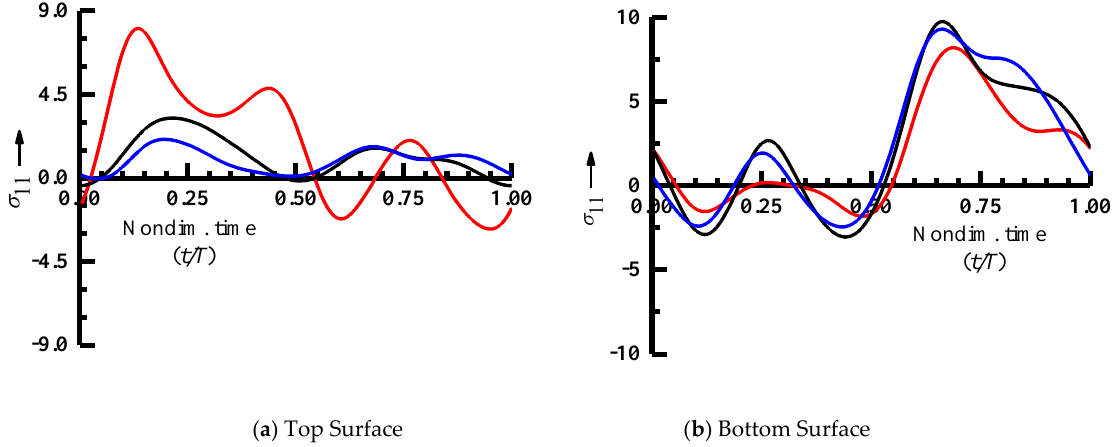
The center of the bottom surface is subjected to partly tensile and partly compressive stress during a periodic cycle with a greater tensile portion during a cycle for all the sector angles considered. The stress amplitude at the center of the bottom surface is smaller for the sector plate with a sector angle of 60 ◦ compared to a sector angle of 90 ◦ and 120 ◦ . Furthermore, there are multiple slope changes and stress reversals during a periodic cycle corresponding to a single loading cycle for laminated annular sector plates for all the sector angles considered, revealing significantly large higher harmonic contributions. The Fast Fourier Transform of the steady state stress at the center of the top and bottom surface is presented in Figure 9. It can be seen that, at the top surface the second harmonic contribution is greater than the fundamental harmonic level for sector angle 90 ◦ and 120 ◦ , which may be due to greater involvement of quadratic nonlinear restoring forces compared to linear restoring forces. However, at the center of the top surface corresponding to the peak amplitude, the sector plate with a sector angle of 60 ◦ depicts significant odd-order harmonic contributions, which may be due to